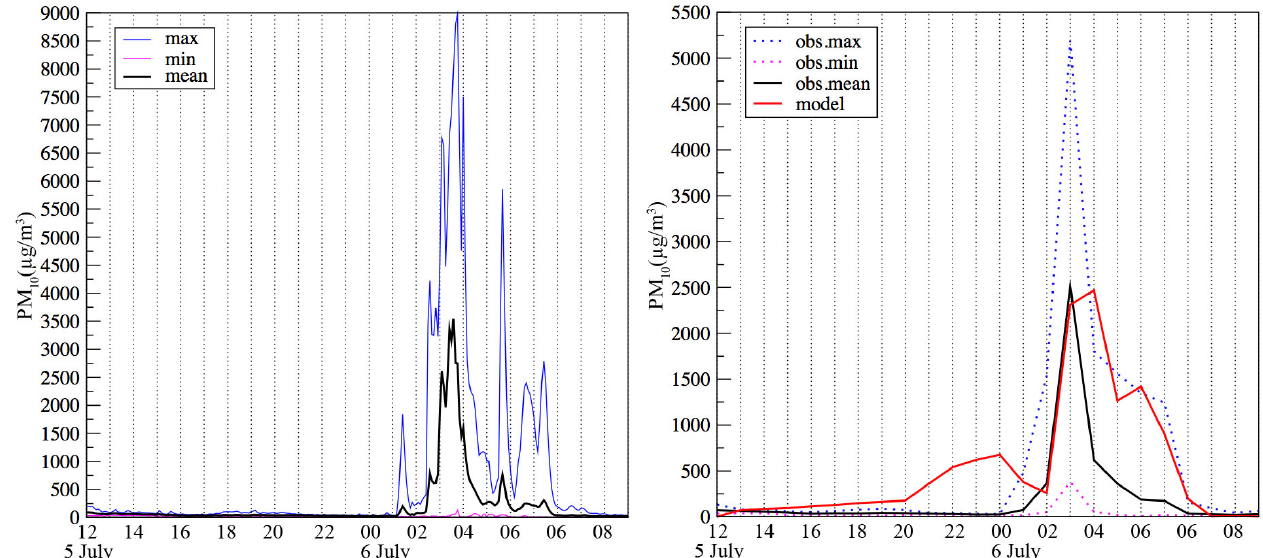
Fig. 8. Observed values of PM 10 on 5 min in all 11 stations in Maricopa (left), and values at full hour with model PM 10 surface dust concentration at selected